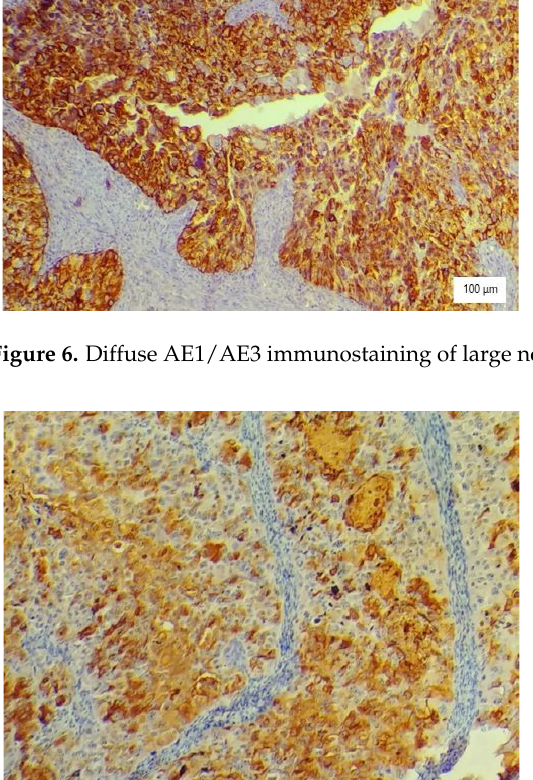
Figure 7. EMA immunostaining of tumor cells with high nuclear grade (×100).